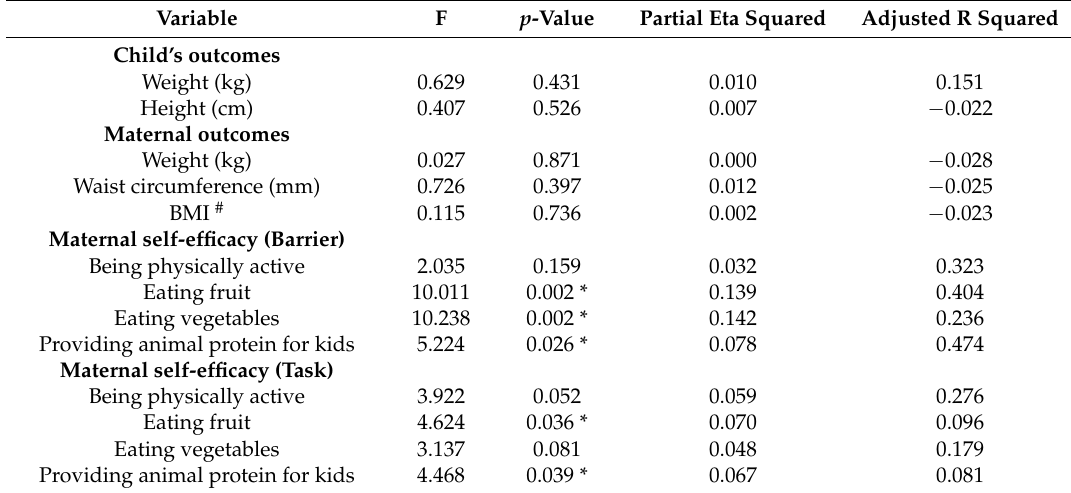
Table 2. The ANCOVA test results on primary outcomes & maternal self-efficacy ( n =